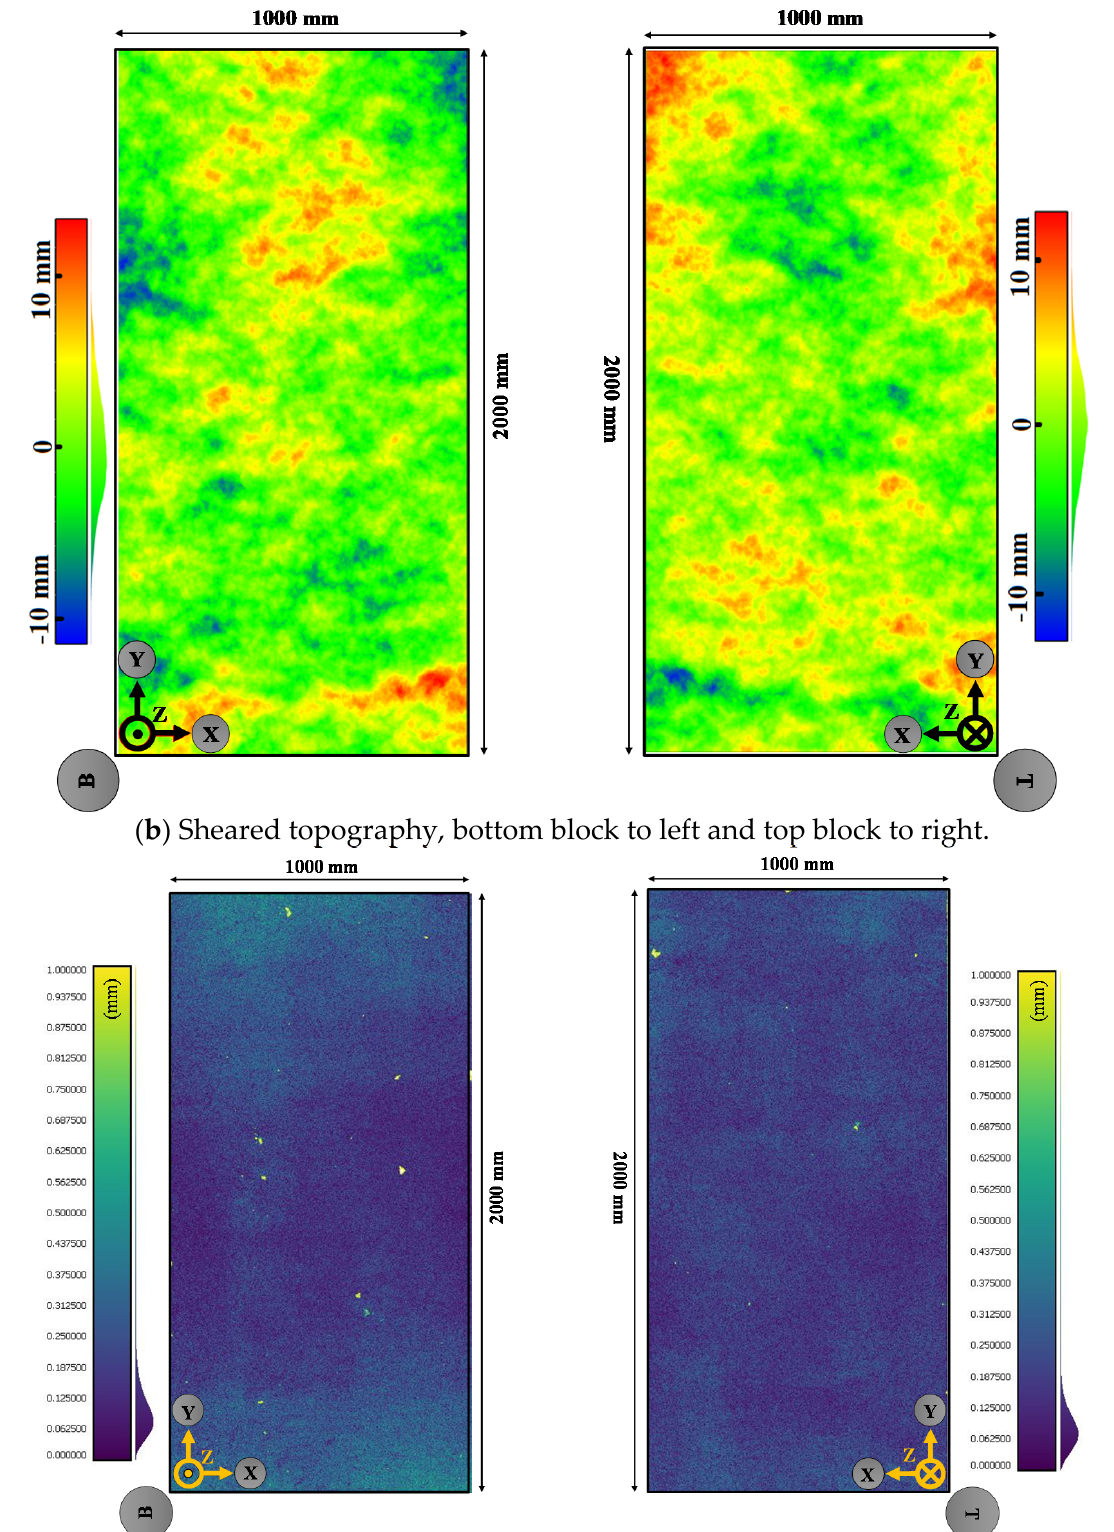
Figure 7. Photogrammetry data of the large sample (2000 mm × 1000 mm), ( a ) initial topography, ( b ) sheared topography and ( c ) damaged areas based on the comparison between pre-shearing and post-shearing stages.